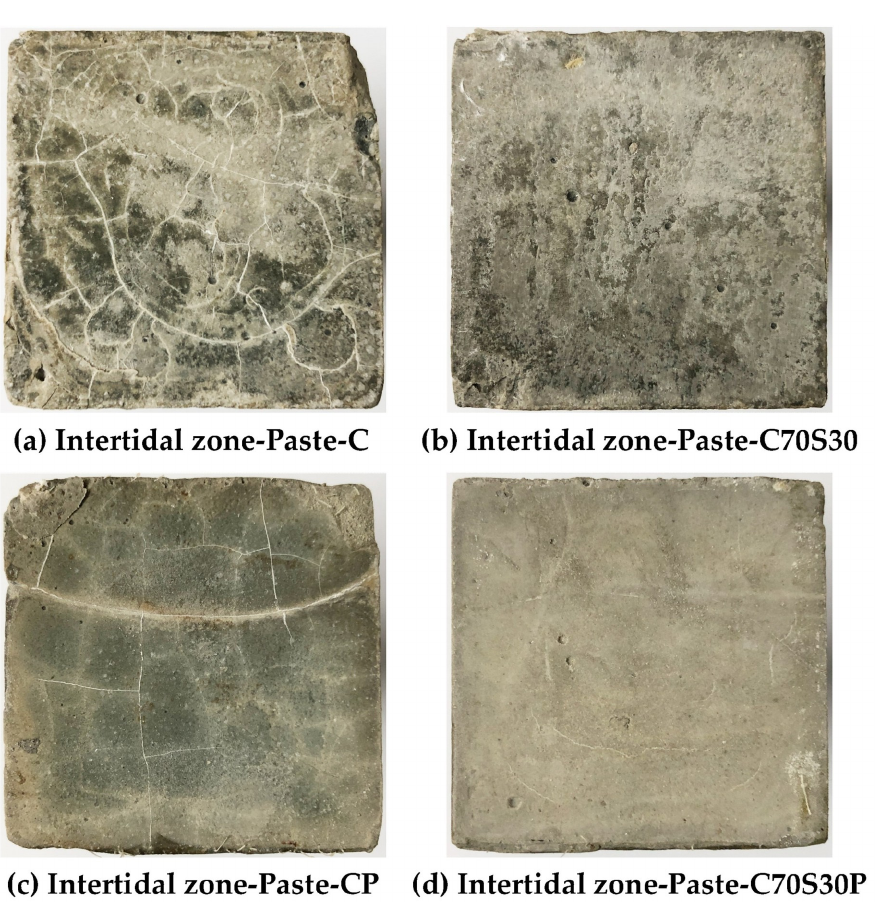
Figure 8. The macroscopic morphology of the exposed surface of CBRM after 180 days of dry–wet cycles-coupled chloride ion